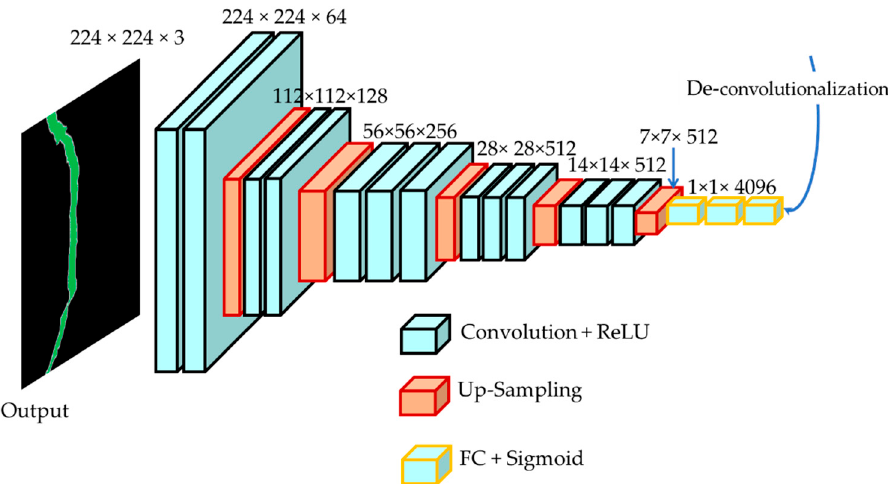
Figure 3. The proposed decoder framework using VGGNet architecture.